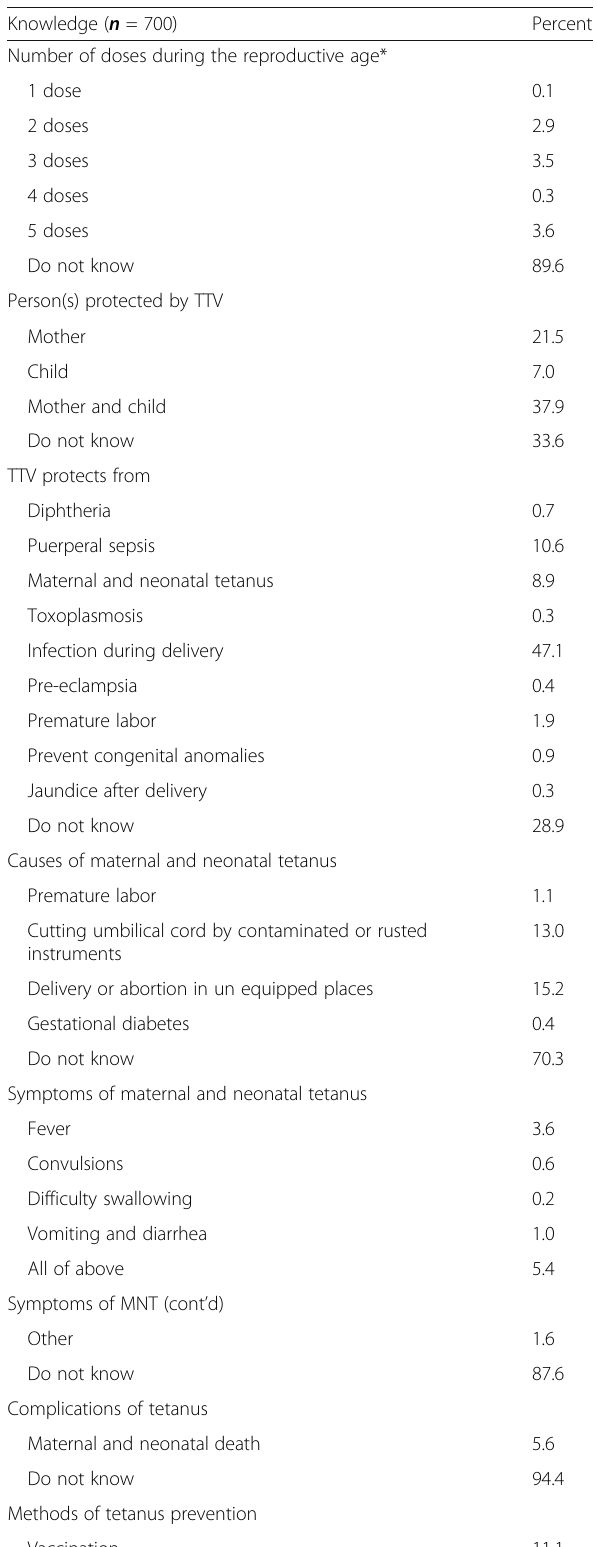
Table 2 Knowledge of reproductive-age women in